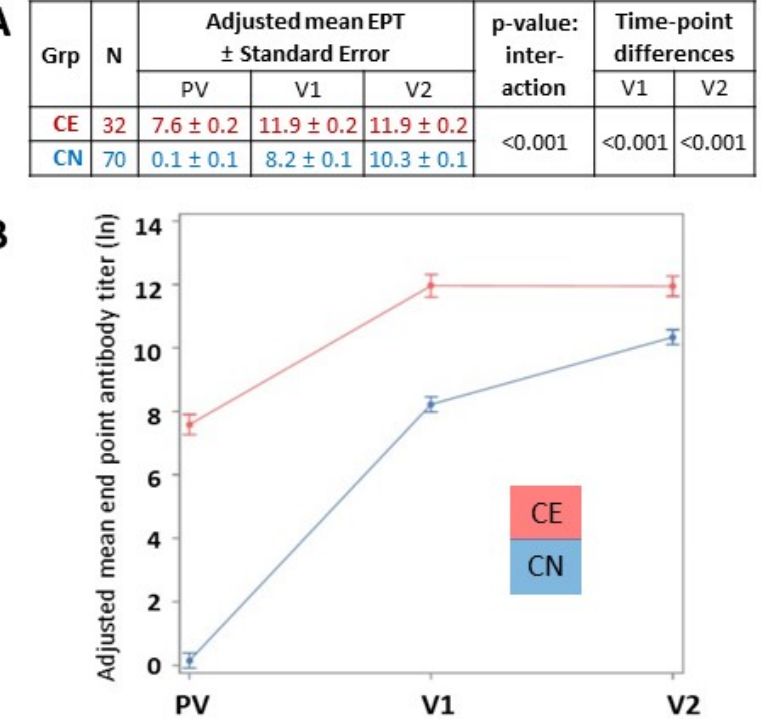
Figure 3. Differences in vaccine response between CE and CN individuals controlling for age, gender, and race. ( A ) The natural log of the adjusted mean antibody EPT ± standard error of COVID-19-experienced (CE; red) and COVID-19-naïve (CN; blue) groups was calculated for samples obtained pre-vaccination (PV), 3 weeks after the first vaccine dose (V1), and 3 weeks after the second vaccine dose (V2). ( B ) The natural log of the mean ±95% confidence interval is graphed (y-axis).